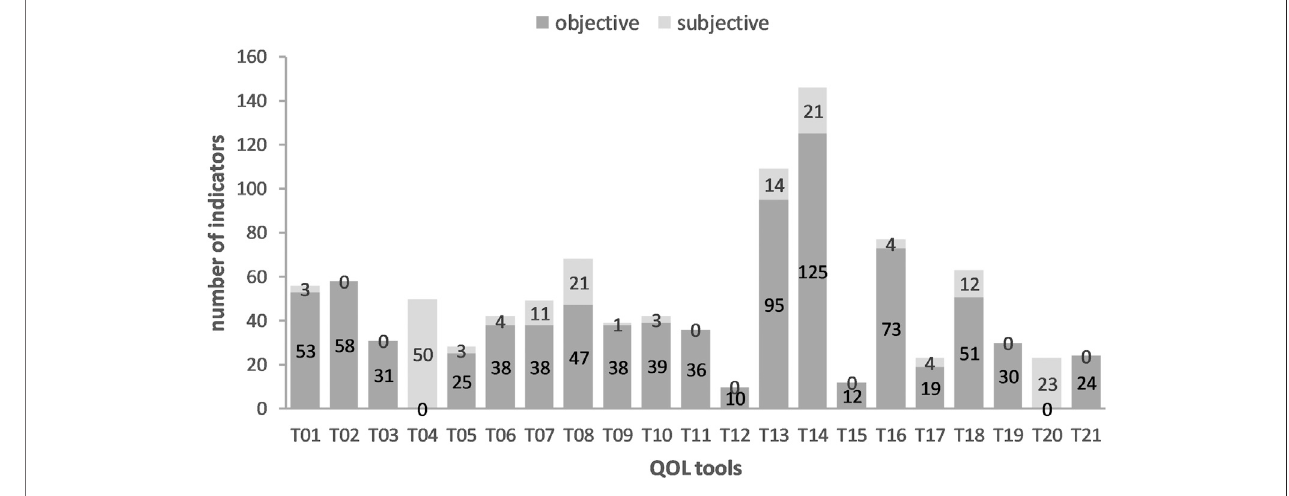
FIGURE 6 | Structure of the examined tools: objective vs.